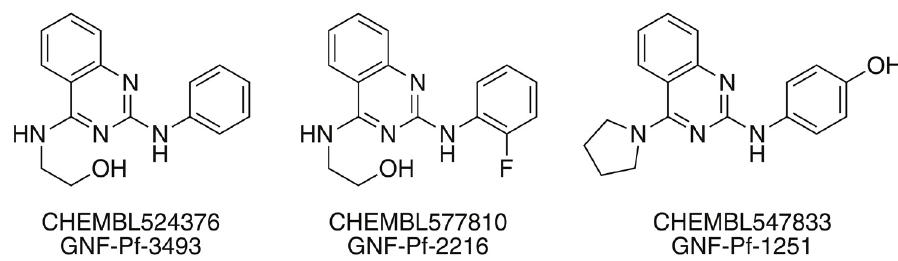
Figure 4. Compounds from the Novartis-GNF Malaria Box 40 , with an aminopyrimidine-type scaffold. These compounds are similar to the group of compounds predicted by Workflow 1 with the same scaffold (Table 6).